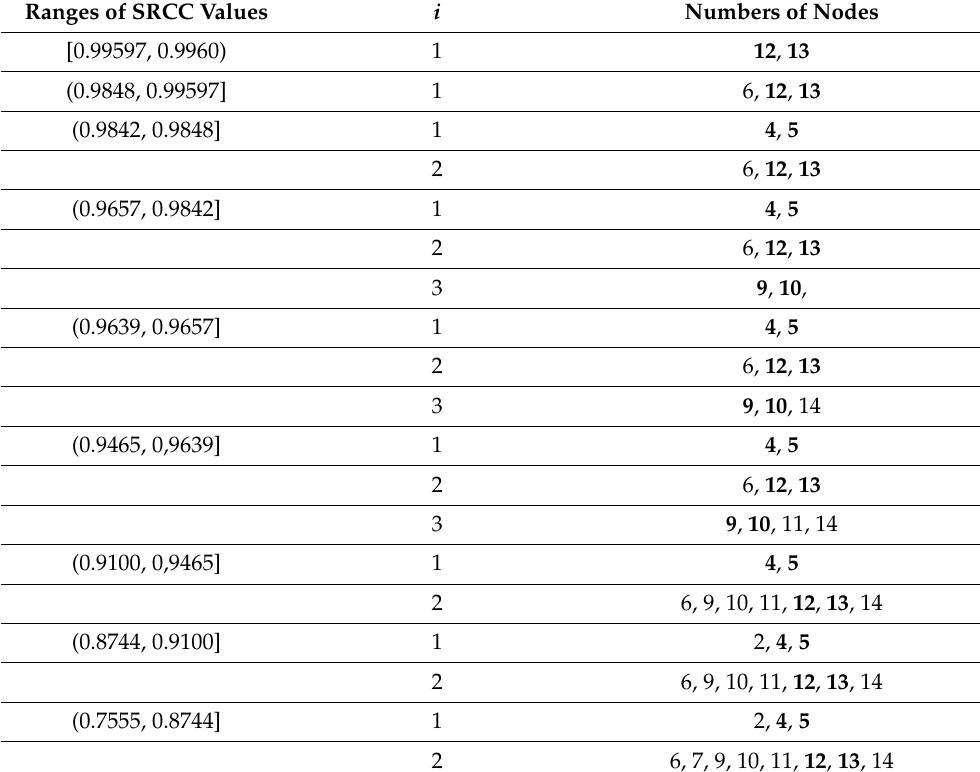
Table 6. Consistent areas of the considered power system defined by (16) for different ranges of SRCC